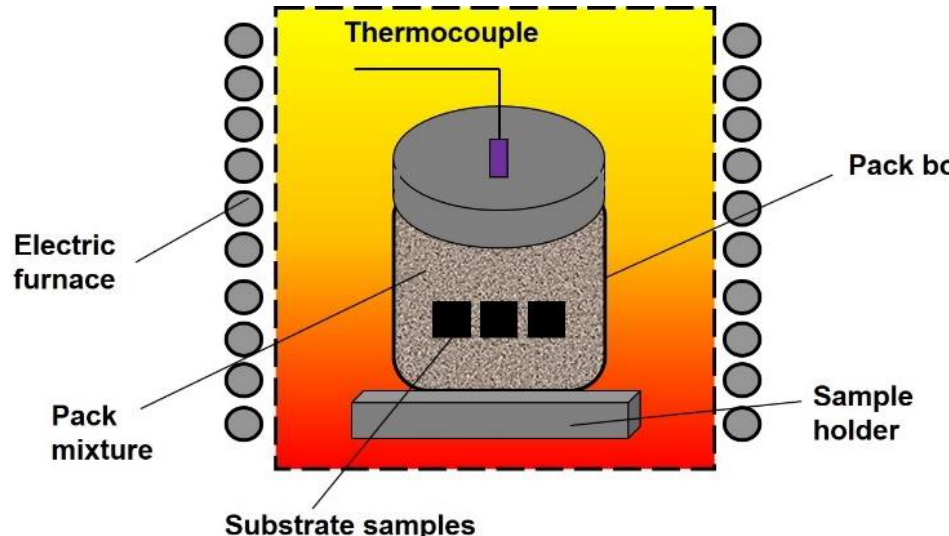
Figure 1. Schematic representing pack cementation process.